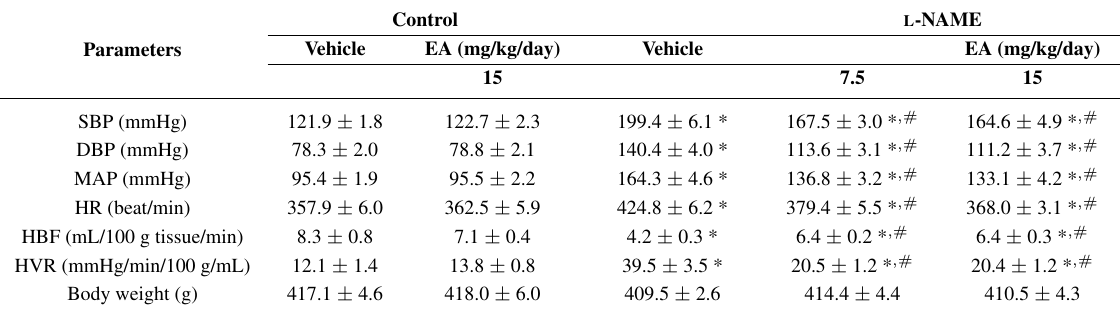
Table 1. Effect of ellagic acid on cardiovascular parameters and body weight. Parameters